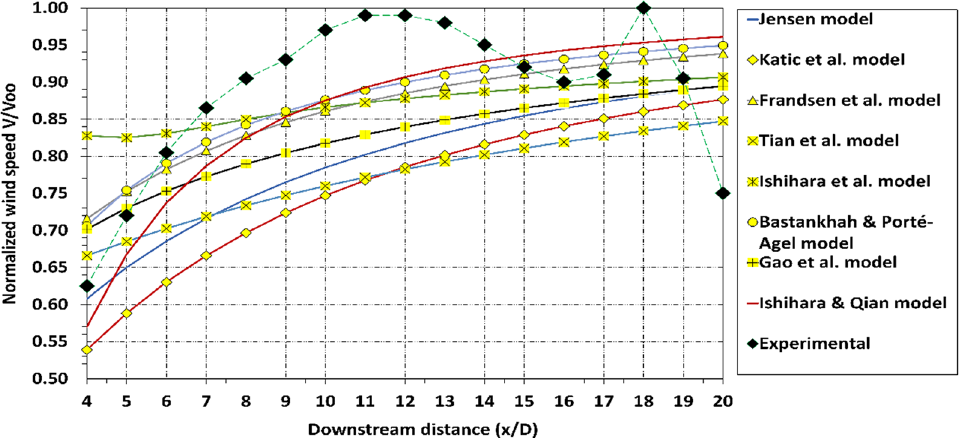
Fig. 4. Experimental and calculated wake development for upstream wind speed value equal